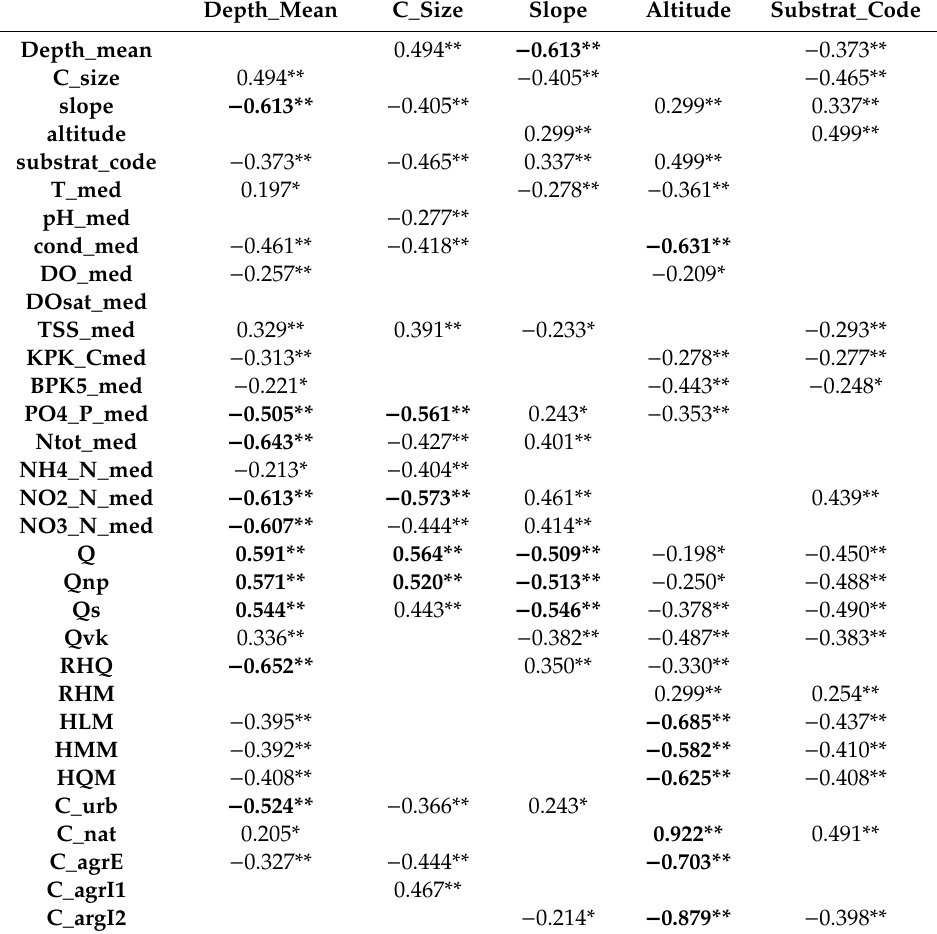
Table A3. Statistically significant Spearman’s correlation coe ffi cients (RSp) for the combinations of Table 2 for environmental variable codes.